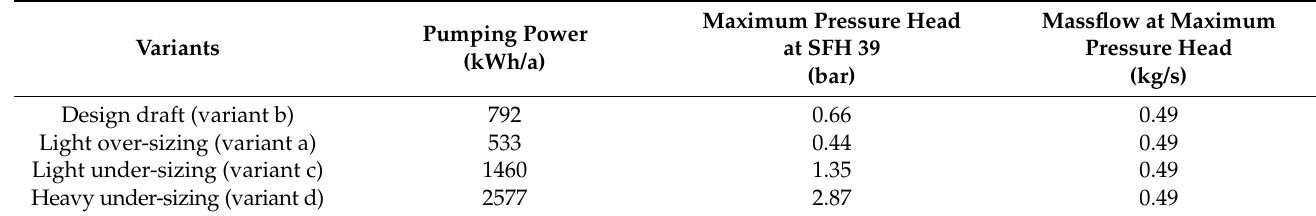
Table 2. Comparison of the different pipe sizing variants for a decentralized pump